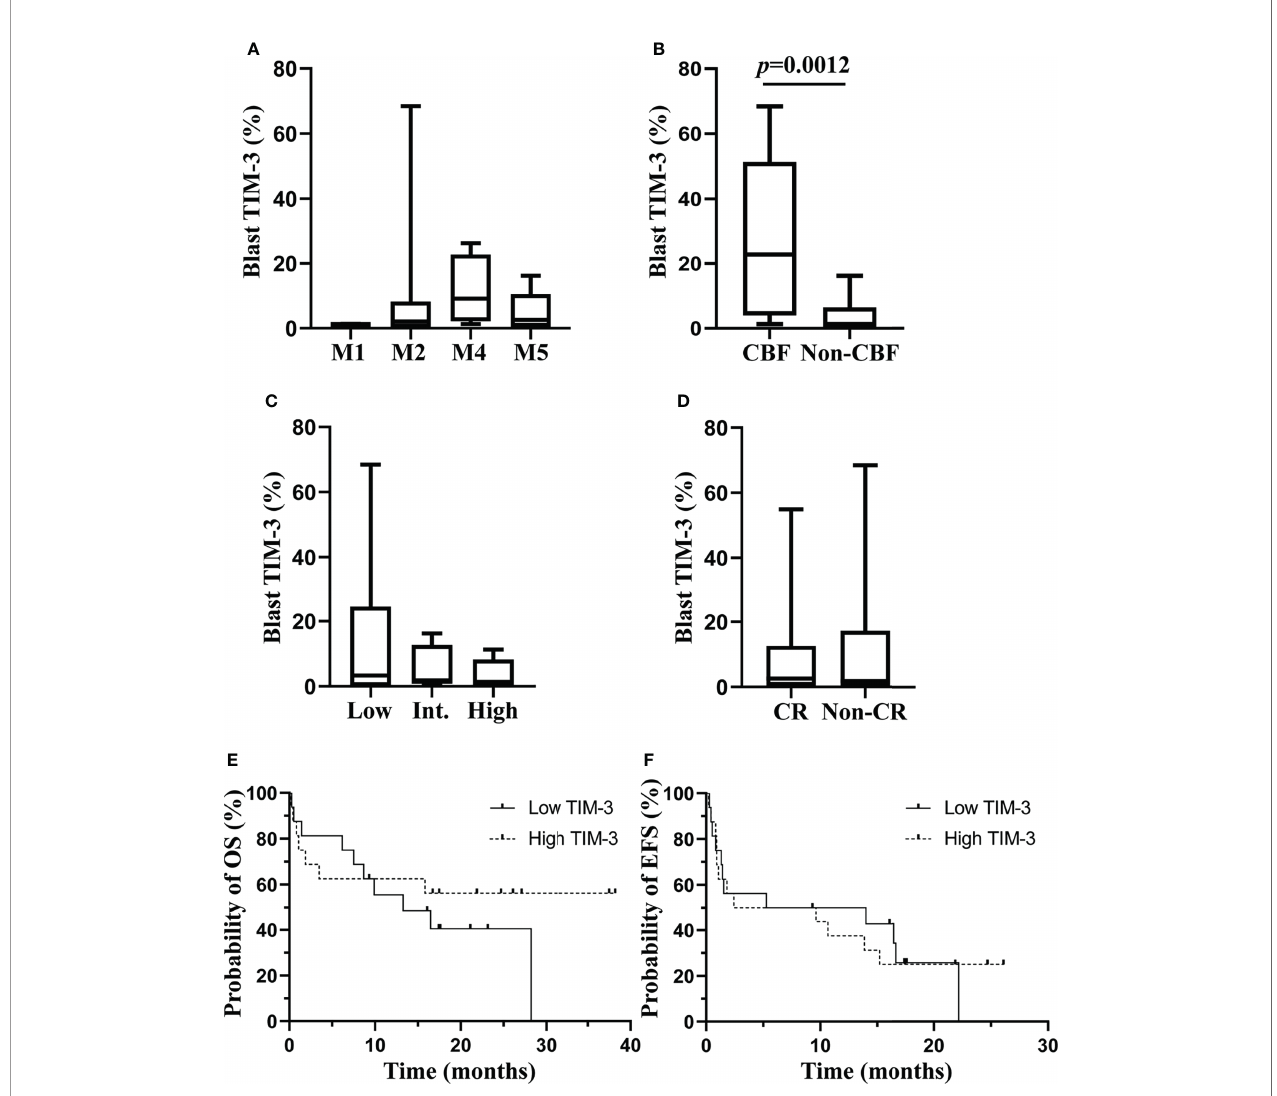
FIGURE 3 | Associations of TIM-3 expression level of leukemic blasts with clinical parameters of AML patients. TIM-3 expression levels of leukemic blasts in FAB subtypes are shown in (A) . TIM-3 expression levels of leukemic blasts in patients with or without CBF translocations are shown in (B) . TIM-3 expression levels of leukemic blasts in ELN risk groups are shown in (C) . A total of 32 AML patients received the induction chemotherapy, and 18 patients were CR, 9 patients were non-CR and 5 patients died during the induction chemotherapy. TIM-3 expression levels of leukemic blasts in patients who achieved CR or not after induction chemotherapy are shown in (D) . These patients were divided into low and high TIM-3 groups based on the median TIM-3 expression level. Probabilities of OS and EFS of two groups are shown in (E) and (F) , respectively. (A – D) Box and whisker plots are used to show the data. Boxes represent the interquartile range, lines inside the boxes represent the median, and whiskers represent minimum and maximum values. CBF, core-binding factor; CR, complete remission; EFS, event-free survival; Int, intermediate; OS, overall